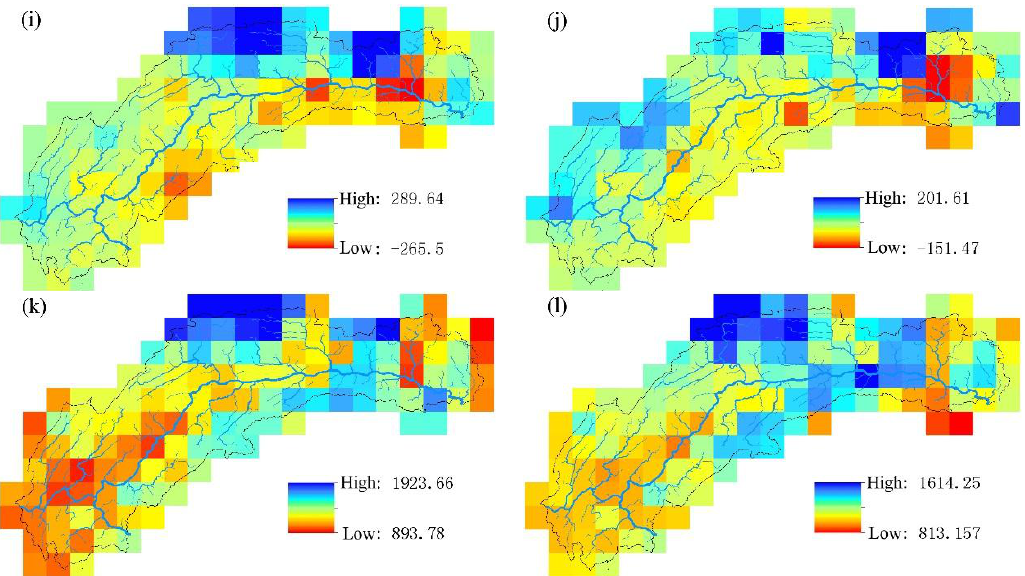
Figure 9. Multi-year average annual precipitation interpolation results in the Three Gorges Region